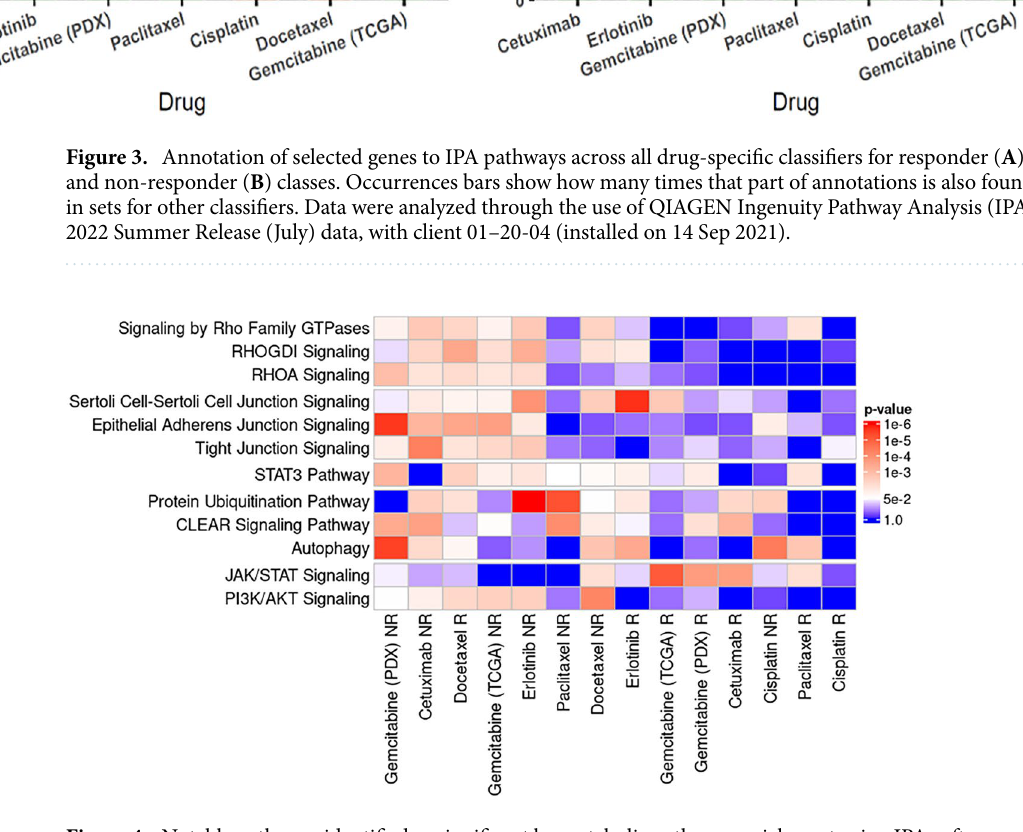
Figure 4. Notable pathways identified as significant by metabolic pathway enrichment using IPA software in gene sets of importance in multiple prediction models. Data were analyzed through the use of QIAGEN Ingenuity Pathway Analysis (IPA), 2022 Summer Release (July) data, with client 01–20-04 (installed on 14 Sep